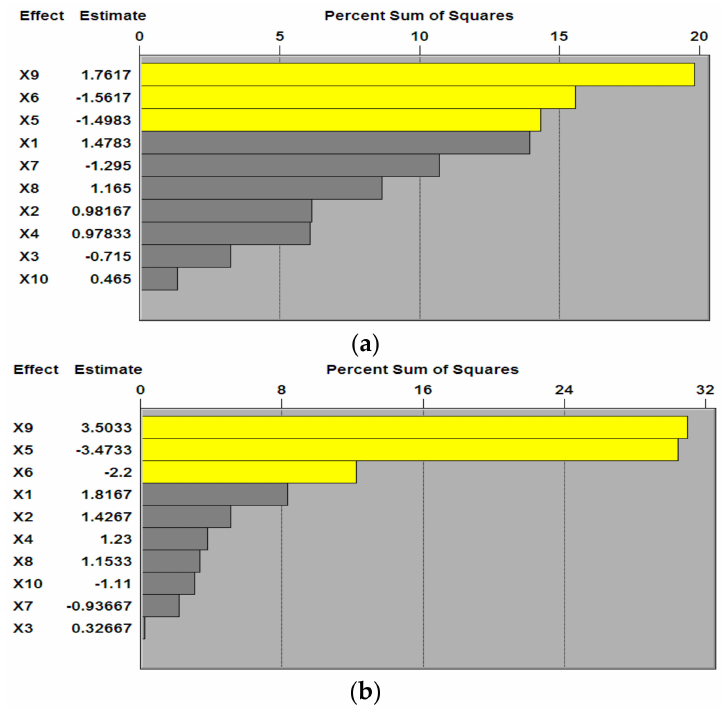
Figure 1. The effect of variable factors on the hydroxyl free radical scavenging rate ( a ) and DPPH radical scavenging rate ( b